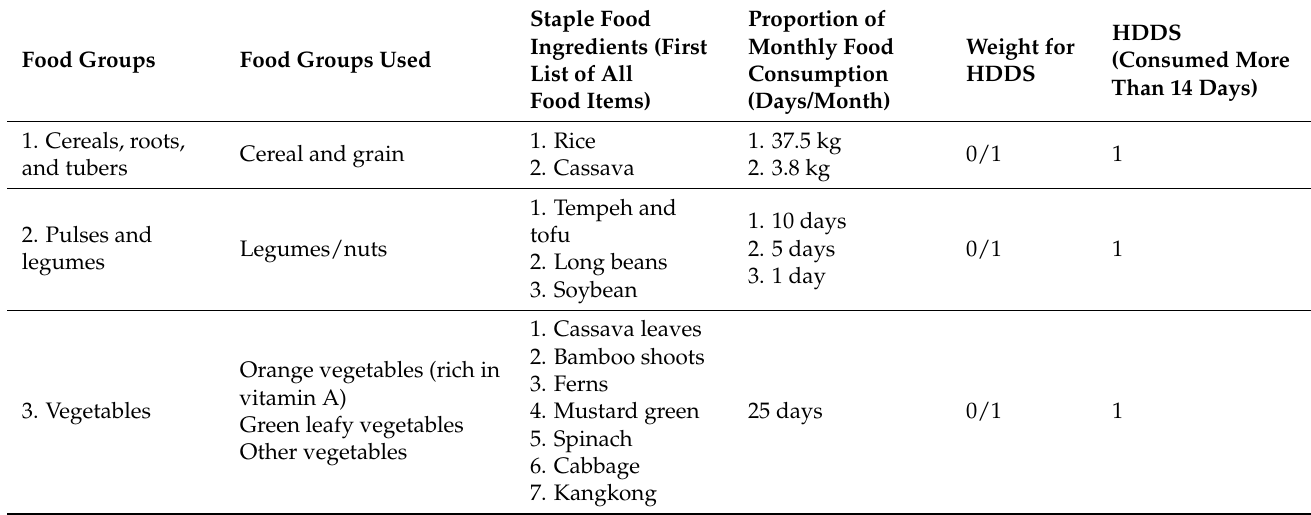
Table 12. Current HDDS of the community in the Kenaman